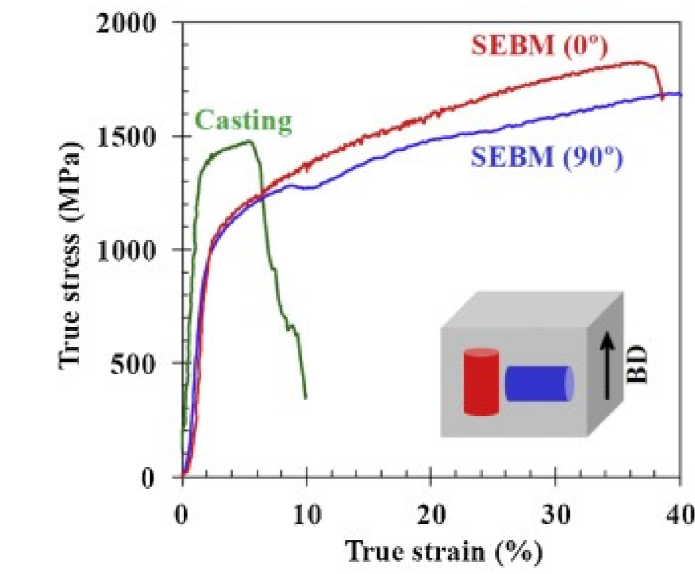
Figure 13. True stress–strain plot of AlCoCrFeNi HEA fabricated using selective electron beam melting (SEBM) for samples whose cylinder axes were parallel (SEBM (0 ◦ )) and perpendicular to the build direction (SEBM (90 ◦ )) and compared with as-cast sample. Reprinted with permission from ref. [343]. Copyright 2021